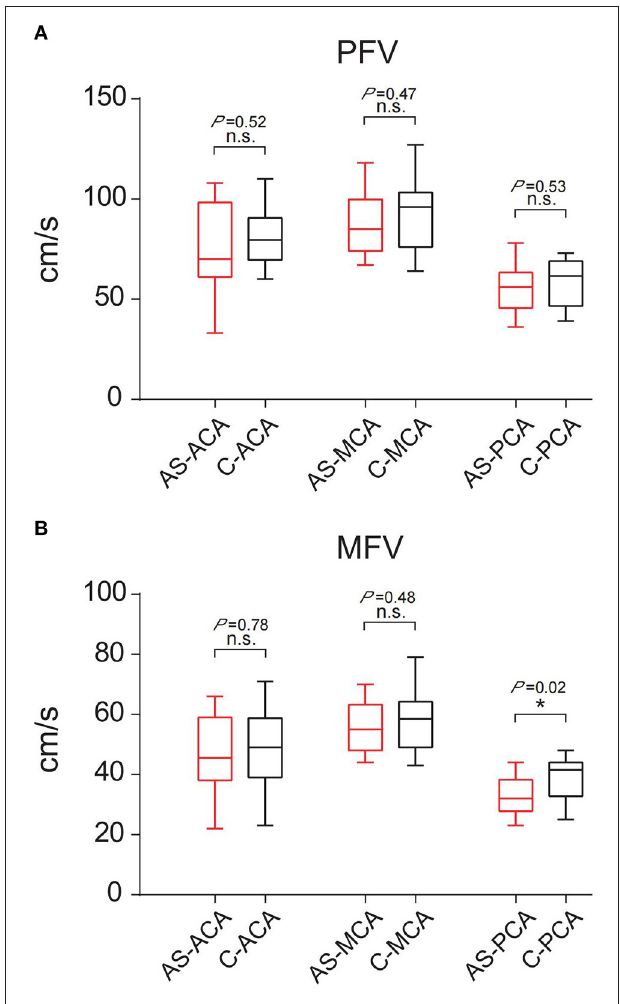
FIGURE 3 | Comparison of PFV and MFV of the corresponding vessels on the low metabolic side and contralateral side of PET. (A) PFV. (B) MFV. “*”: P < 0.05 ; n.s., no statistical significance; AS, abnormal side; C, contralateral; ACA, anterior cerebral artery; MCA, middle cerebral artery; PCA, posterior cerebral